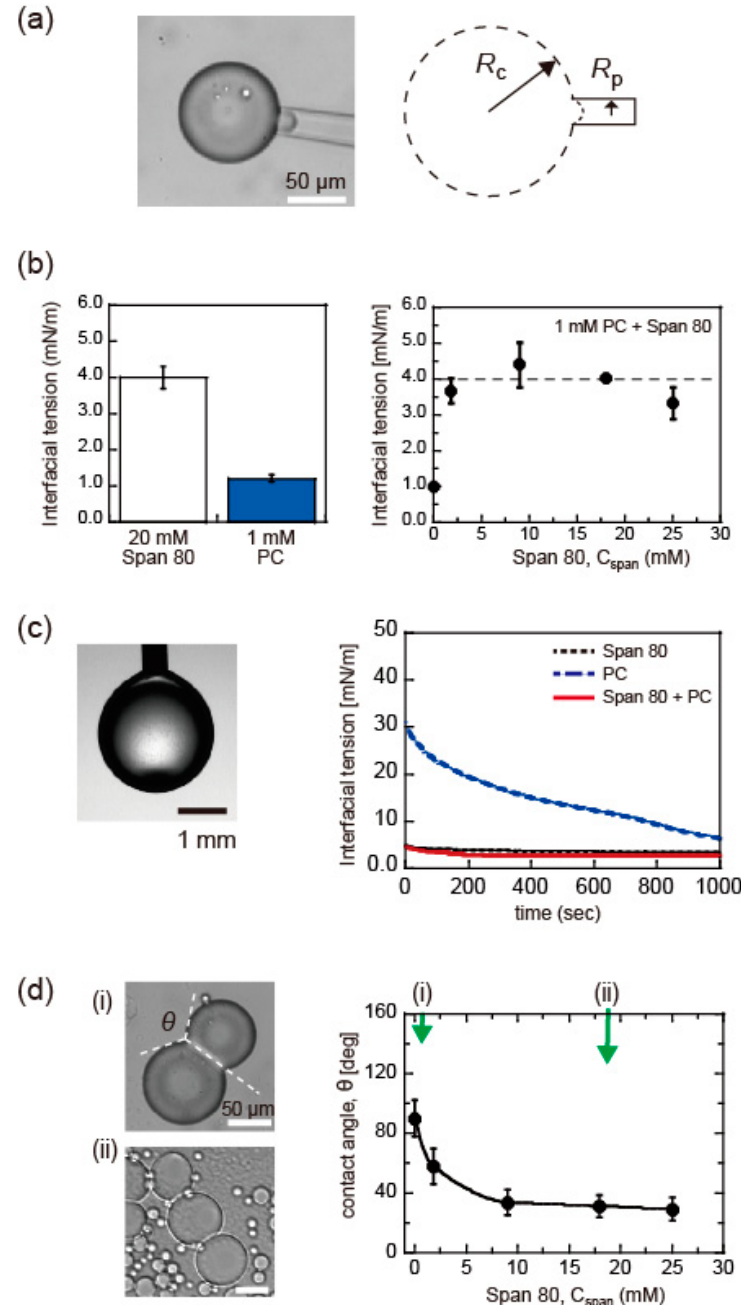
Figure 4. ( a ) Interfacial tension measurement by micropipette aspiration, where droplet radius R c and inner radius of micropipette R p are analyzed. ( b ) Values of interfacial tension (Average (Ave.). ± standard deviation (SD), n > 5) using micropipette aspiration for 20 mM Span 80 droplets, 1 mM PC droplets (left), and droplets with a mixture of 1 mM PC and various concentrations of Span 80, C span (right). The broken line shows the value interfacial tension for 20 mM Span 80 (i.e., 4.0 mN/m). ( c ) Dynamic interfacial tension measurement using the pendant droplet method for 20 mM Span 80 (black dashed line), 1 mM PC (blue broken line), and their mixture (solid red line). ( d ) (left) Bright field images of DIB-bounded droplets for (i) 1 mM PC and (ii) a mixture of 1mM PC and ~18 mM Span 80, respectively. (right) Contact angle θ (Ave. ± SD, n > 5) for DIB-bounded droplets of a mixture of 1 mM PC and various concentrations of Span 80, C span